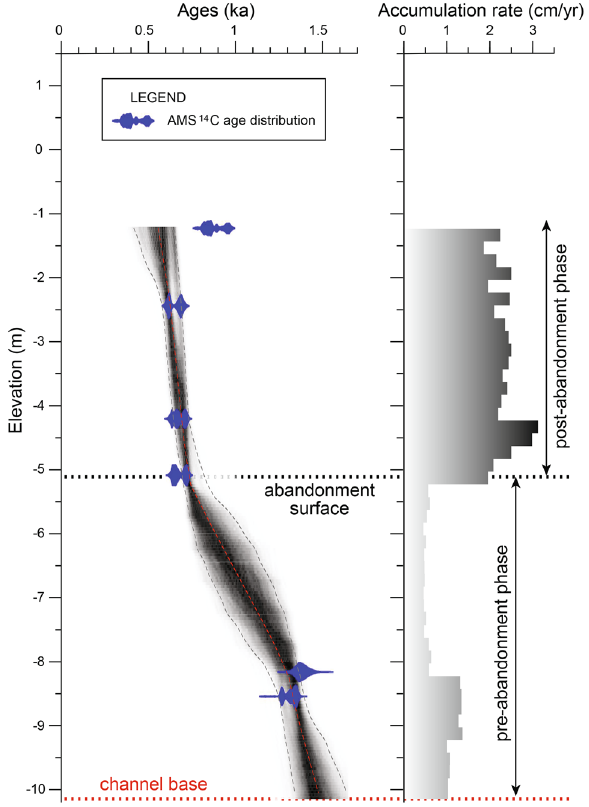
Figure 7. Age-depth model and sediment accumulation rates of the core BL2 based on the AMS 14 C ages.